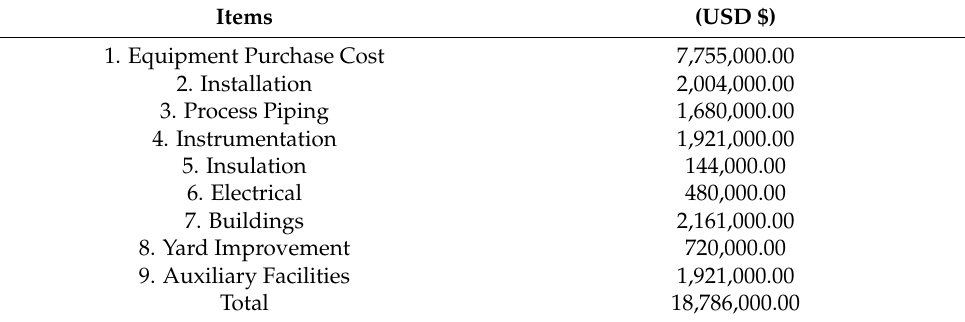
Table 1. Total direct plant cost (TPDC) (infrastructure costs).